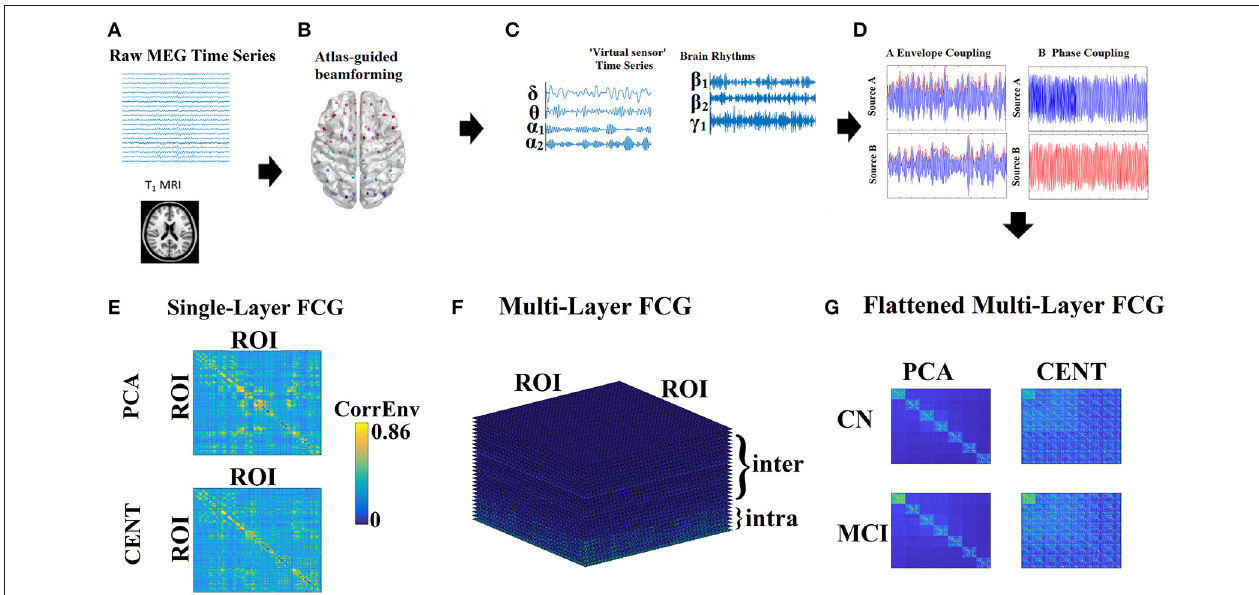
FIGURE 1 | From MEG recordings to single-layer and multi-layer FCG. (A) Raw MEG time series recordings and T1 MRI image. (B) Atlas-guided beamforming (here AAL-90 template). (C) Virtual sensors time series for each brain rhythm. (D) Estimation of the functional connectivity with the CorrEnv based on the Hilbert envelope and the iPLV based on the Hilbert phase time series. (E) Single-layer FCG: an example from a healthy control subject in the δ frequency band demonstrating both types of ROI representation for contrast. (F) Multi-Layer FCG: in our study, we used 7 intra-frequency intrinsic coupling modes and 21 inter-frequency coupling modes, leading to 28 in total. (G) Flattened Multi-Layer FCG: The dimension of the flattened Multi-Layer FCG equals {Coupling Modes × ROI} × {Coupling Modes × ROI}, where in the main diagonal FCG of intra-frequency coupling modes are inserted while in the off-diagonal FCG of inter-frequency coupling modes are encapsulated. Where Coupling Modes = 28 intra and inter-frequency FCG. PCA, principal component analysis; CENT, centroid; CN, control; MCI, mild cognitive impairment.